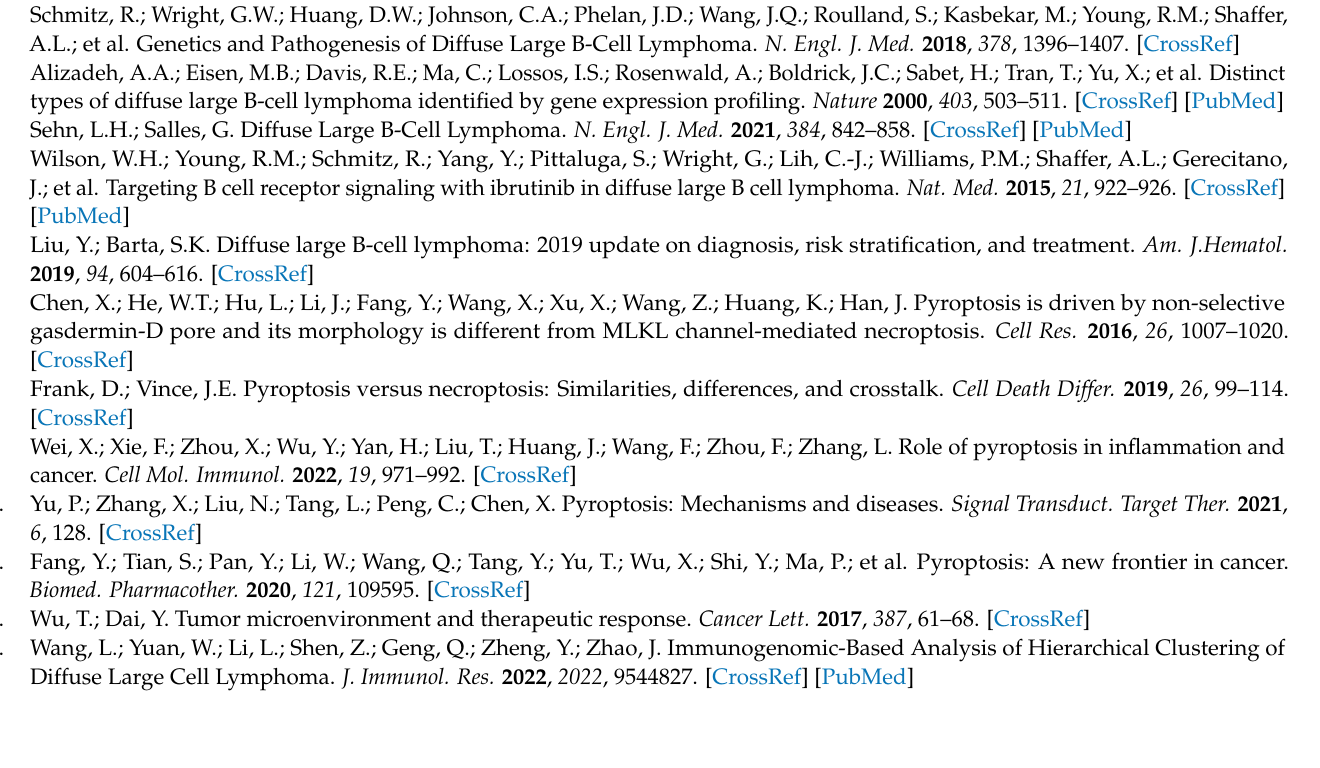
Ridge regression model; Figure S2: Comparison of expression of 8 PRGs in ABC and GBC cell lines; Figure S3: Calibration comparison of nomogram; Table S1: List of pyroptosis related genes obtained from GeneCards.xlsx; Table S2: Results of Cox univariate regression of 24 prognostic pyroptosis related genes.xlsx; Table S3: List of GO pathway enrichment.txt; Table S4: List of KEGG pathway enrichment.txt; Table S5: Coefficient of genes in lasso regression model.xlsx; Table S6: Patients id of IHC images obtained from HPA database.xlsx; Table S7: Results of protein-protein interaction between 8 PRGs and master genes of DLBCL.xlsx; Table S8: Gene list of immune components for ssGSEA analysis.xlsx. Supplementary File S1: Publication License of Figure